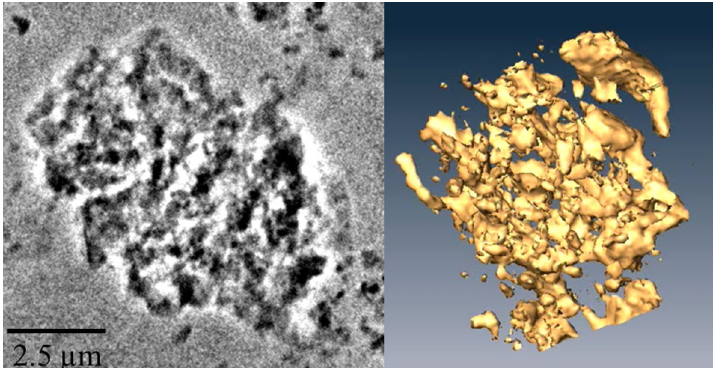
Figure 4. (Left) A 2D micrograph of a natural allophane-dominated microaggregate (extracted from the Bw1 horizon of the soil at Tapapa) obtained using TXM. Dark shadow represents the absorption of 1.84 keV (silicon K -edge) and thus the structure/shape of silicate-based clay, and the white areas are silicate-free compounds (potentially ferrihydrite) and pores. (Right) A 3D virtual reconstruction of the microaggregate obtained